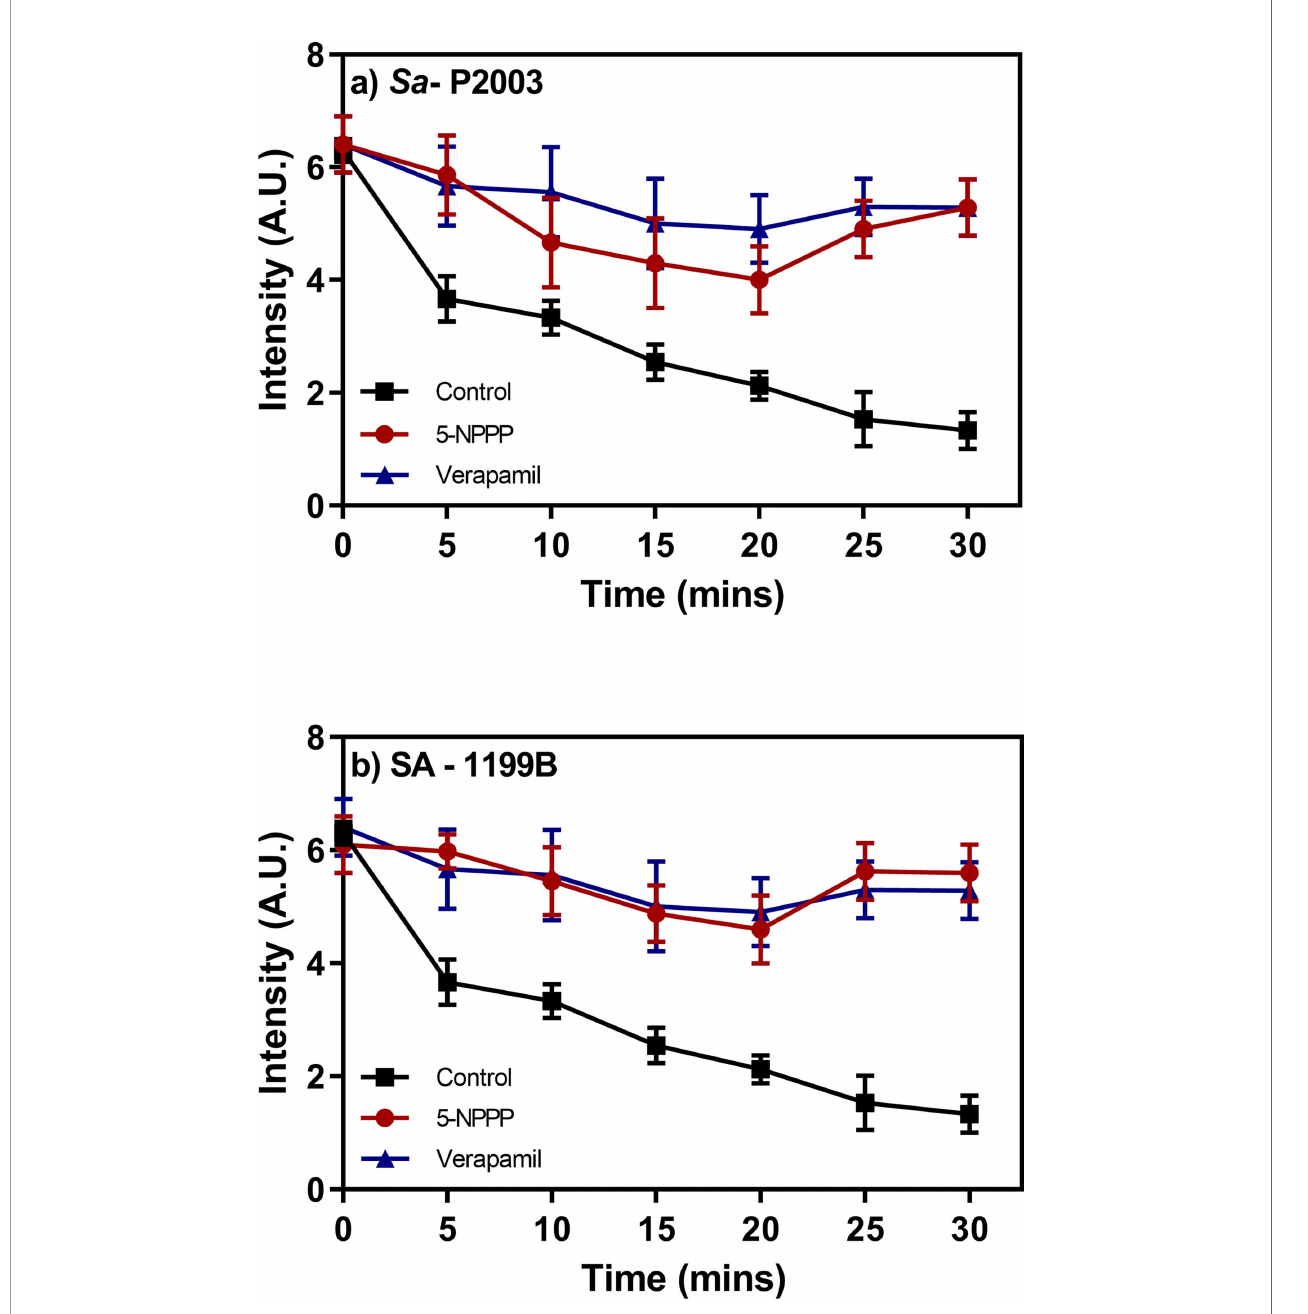
FIGURE 5 | Evaluation of the effect of the identi fi ed NorA ef fl ux pump ef fl ux and the accumulation of ethidium bromide in (A) Sa -P2003 and (B) SA-1199B. Verapamil is included as positive control, and the ef fl ux activity without the addition of any drug is considered as a negative